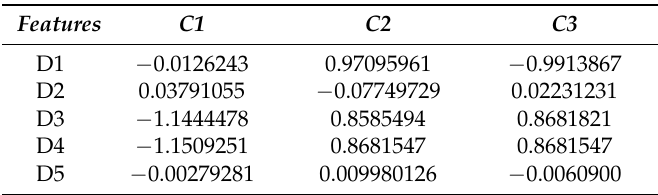
Table 4. Clusters